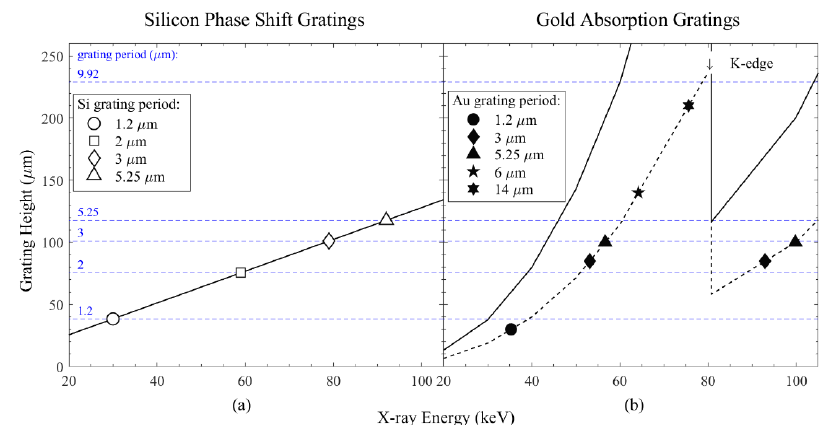
Figure 7. Grating height as a function of X-ray energy range of ( a ) π -phase shift Si gratings (calculated using Equation (6)) and ( b ) absorption gratings, when Si templates are filled with Au (calculated using Equation (7)). The photon intensity reduction is calculated at 1 / e (dotted line) and 1 / e 2 (solid line) absorption level. The empty symbols and horizontal blue lines in ( a ) represent experimental data on Si etched grating reported in this work. The solid dots in ( b ) correspond to Si DRIE gratings filled with Au reported elsewhere (1.2 µ m [49], 3 µ m [50], 5.25 µ m [50], 6 µ m [51], 14 µ m [52]). The projection of the horizontal blue lines from plot ( a ) to plot ( b ) indicates that higher energy coverage can be obtained if the Si gratings produced in this work are filled with Au. (For simplicity, the experimental data points on absorption gratings are illustrated on 1 / e curve only.)